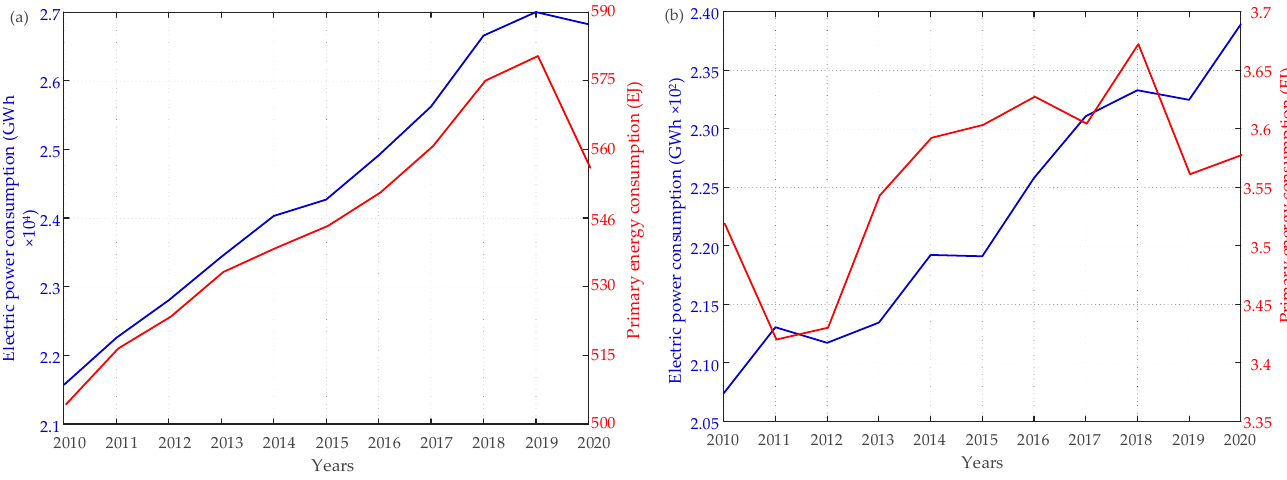
Figure 1. Primary energy and electrical power consumption: ( a ) Global; ( b ) In Taiwan. Source: [1– 4].